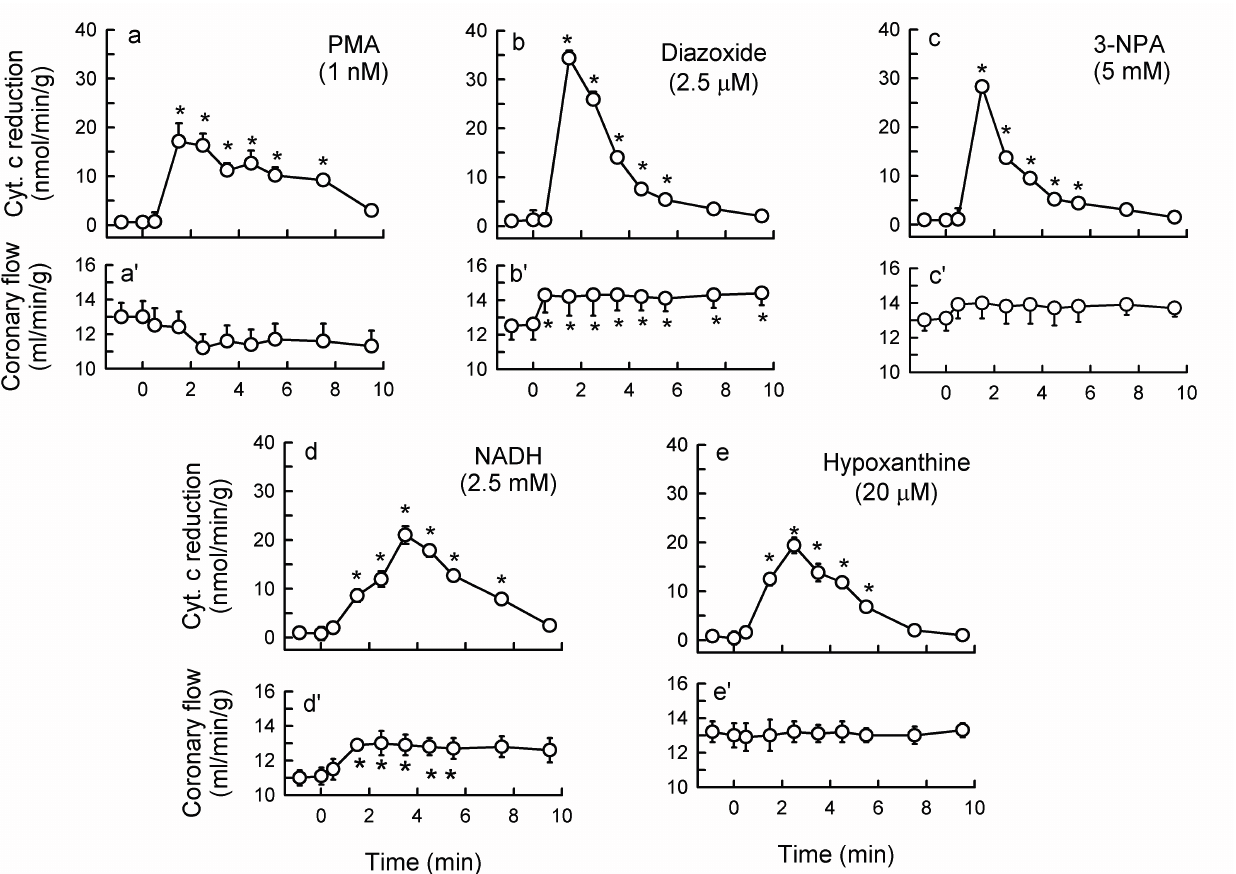
Figure 11. Outflow of reduced cytochrome c ( a – e ) and coronary flow ( a' – e' ) in guinea pig hearts stimulated for 10 min with 1 nM PMA ( a , a' ), 2.5 μ M diazoxide ( b , b' ), 5 mM 3-nitr-propionic acid (3-NPA, c , c' ), 2.5 mM NADH, d , d' ) and 20 μ M hypoxanthine ( e , e'